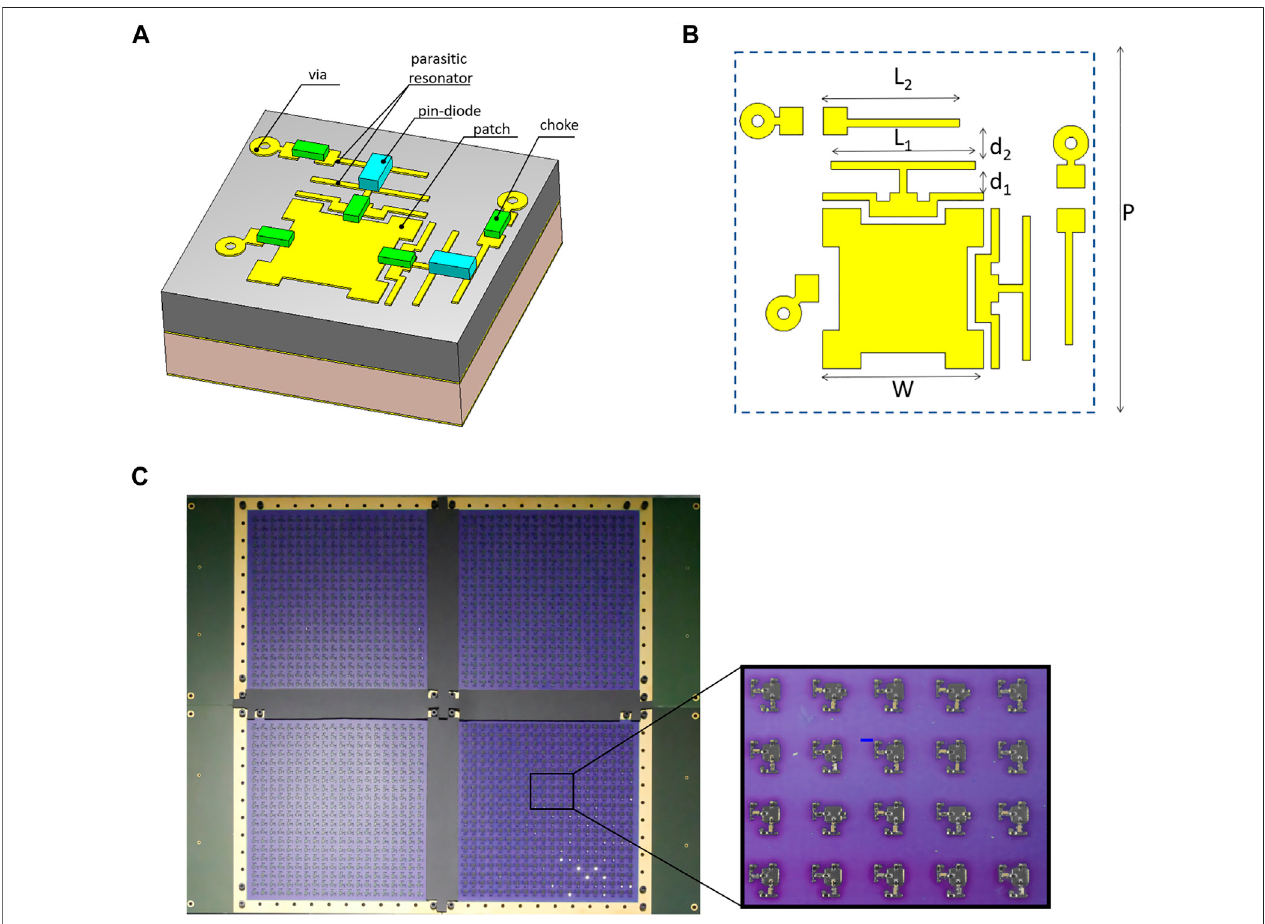
FIGURE1| Theperspectiveview (A) andlayout (B) oftheRISunitcell. (C) Photoofthefabricated20 cm × 20 cmRIScomposedof410 cm × 10 cmre fl ectarrays, controlled by one FPGA board. The total number of unit cells is 1,600, each with independently control of two polarizations.